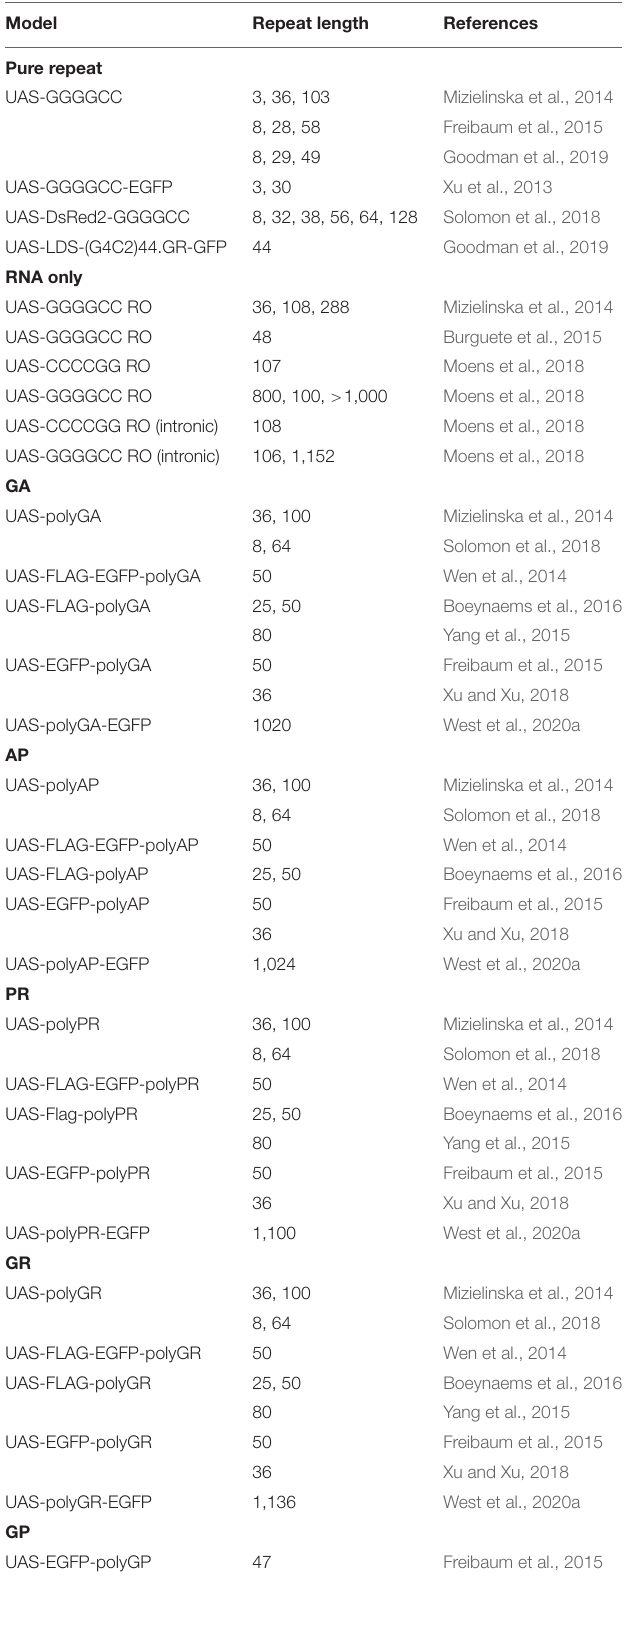
TABLE 2 | Summary of Drosophila models of C9orf72 -related frontotemporal dementia (FTD) and amyotrophic lateral sclerosis (ALS). Model Repeat